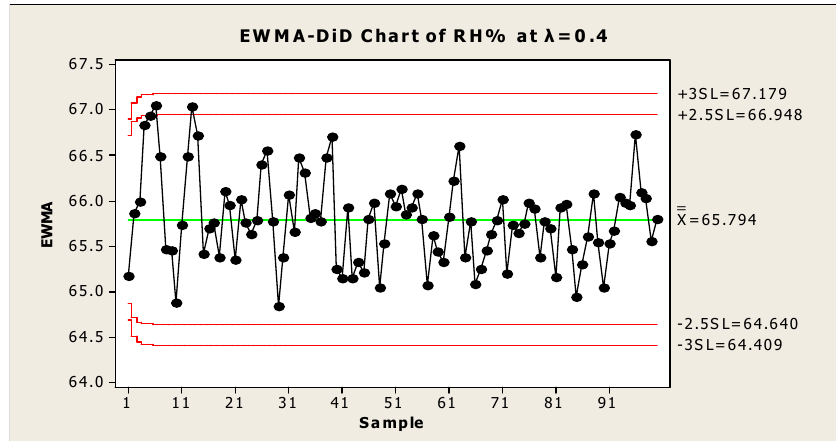
Figure 15. EWMA-DiD Chart of RH% at λ = 0.20.